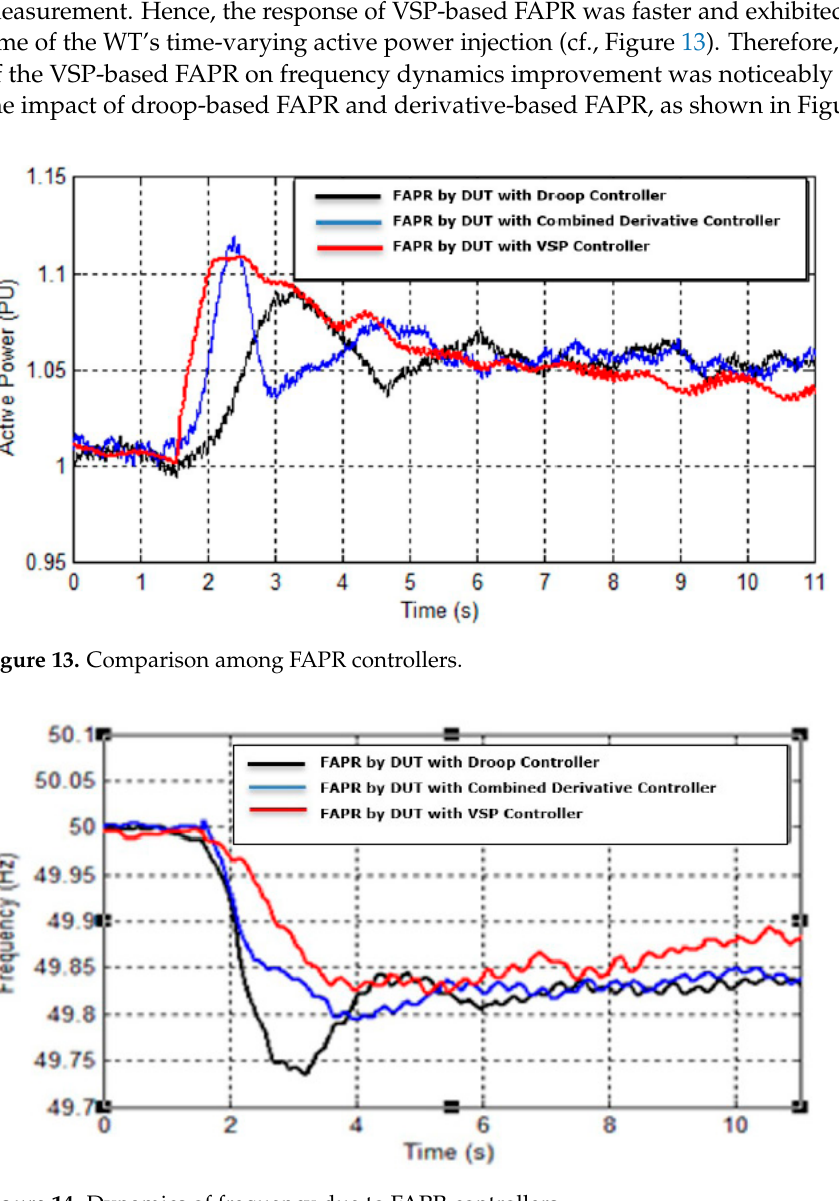
Figure 14. Dynamics of frequency due to FAPR controllers.